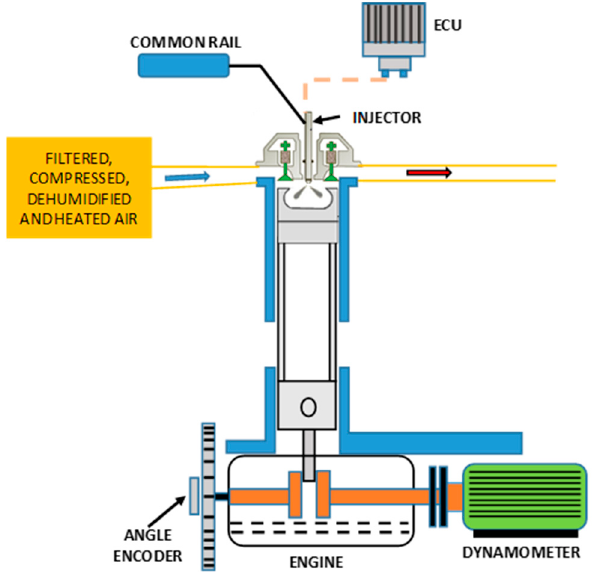
Figure 1. Optical single-cylinder engine [17]. Reprinted with permission from Ref. [17] Copyright 2019 SAE International.